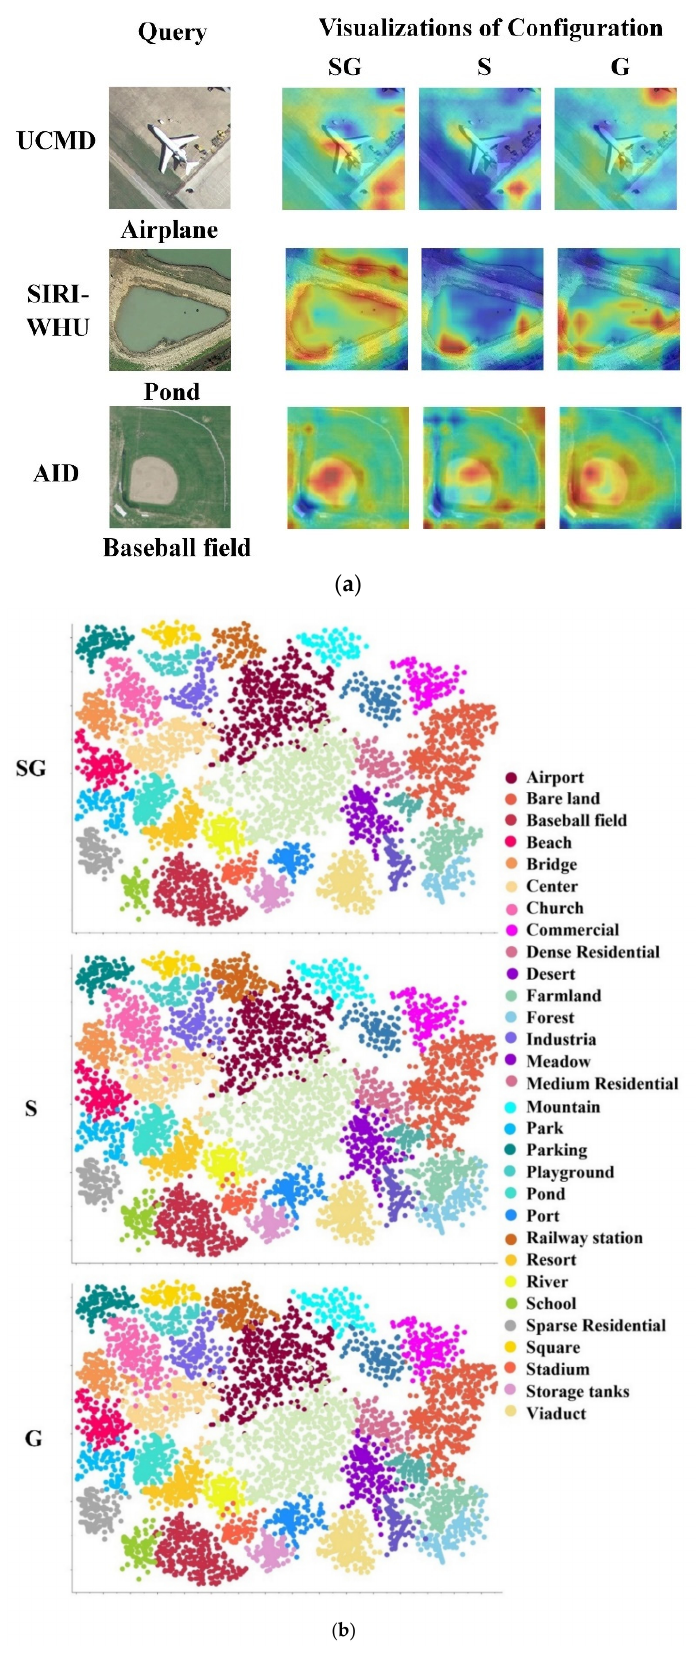
Figure 3. The visualizations of feature discrimination. ( a ) The heatmap and evaluation are provided with configuration SG, S, and G on UCMD, SIRI-WHU, and AID. A more compact feature area